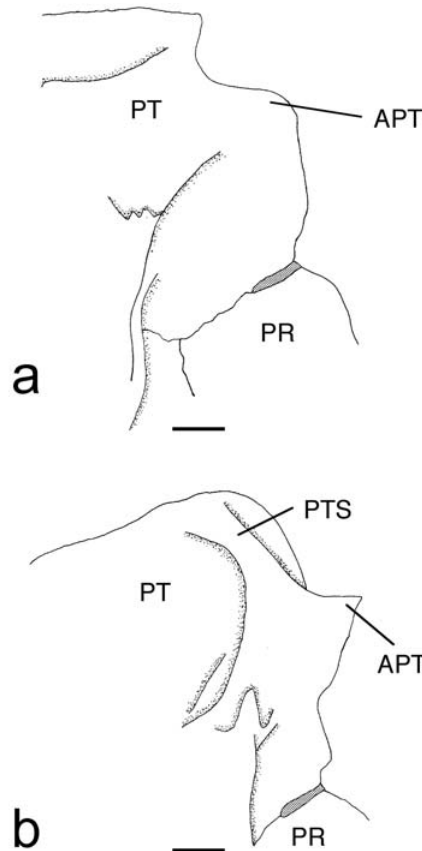
Fig. 1 . Pterotic, right side, ventral view: a. Ancistrus pirareta , UMMZ 206085, b. Lasiancistrus guacharote , INHS 60465. Scale bars = 1 mm. Shaded area is cartilage. APT = anterior process of the pterotics, PR = prootic, PT = pterotics, and PTS = pterotics strut (forms over the open dilatator operculi chamber).